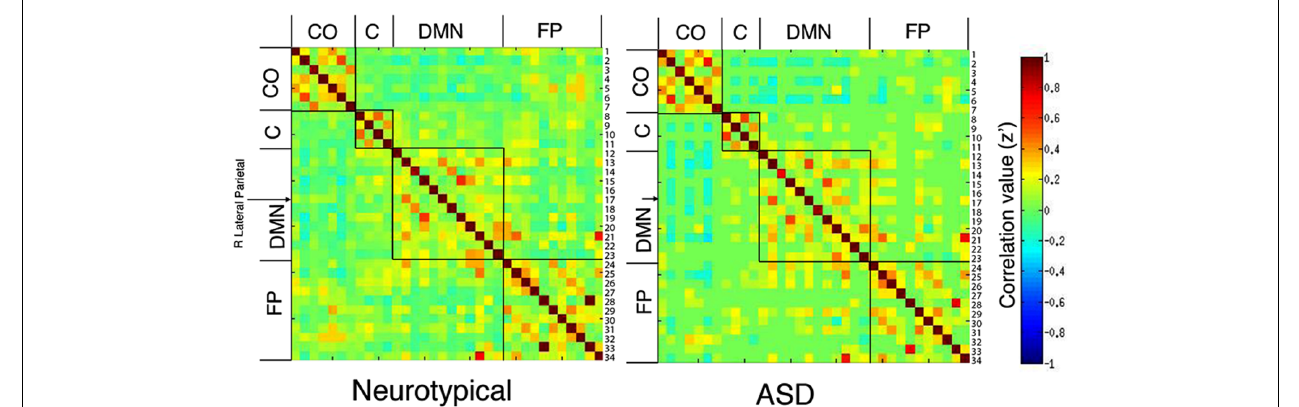
34 seed regions (see Table 2 for a list by number). Comparison of these matrices resulted in no significant differences between groups, when corrected for multiple comparisons.The right lateral parietal seed region (#17) of the DMN is identified with an arrow because that region showed a significant effect of group on centrality measures.